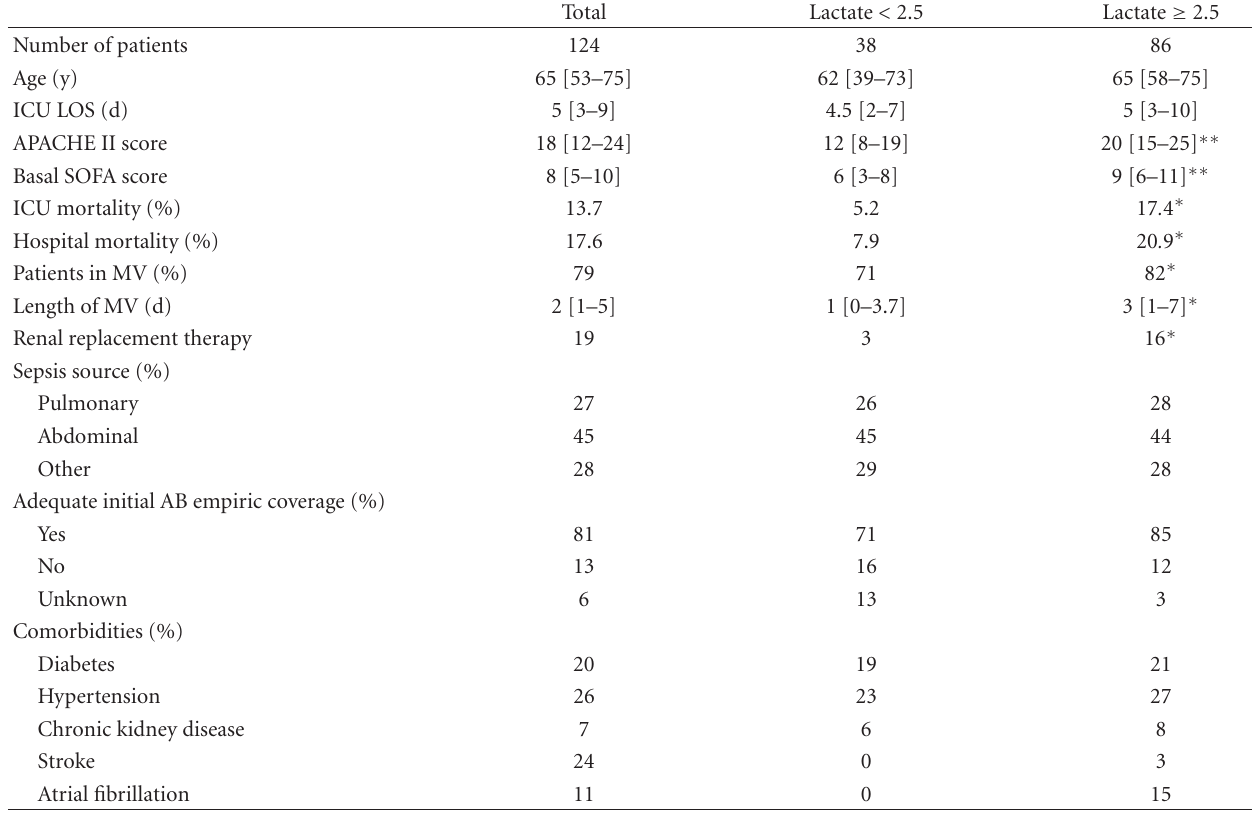
Table 1: General characteristics of the cohort and subgroups of patients.